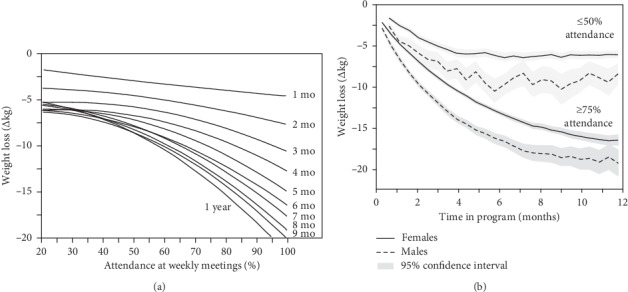
Effects of patient participation on weight loss. (a) The effect of average cumulative attendance on weight change at month 4, month 5,…, 1 year in men and women combined. (b) The average weight loss by month in the high attendees (≥75 attendance at weekly appointments) vs. patients who attended <50% of weekly healthcare coach appointments (low attendance) in men and women separately.